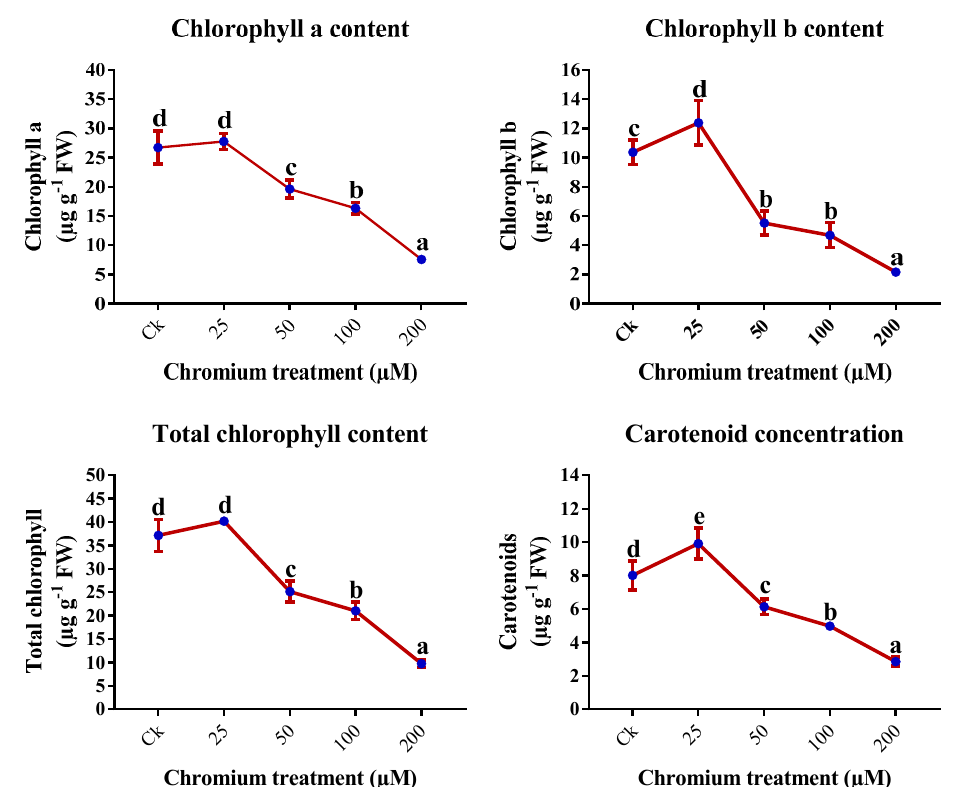
Figure 3. Impact of Cr on the photosynthetic pigments in the leaves of sweet potato. Means followed by different letters indicate a significant difference ( p < 0.05) among the five treatments according to the Tuckey test. Error bars show mean ± SE.